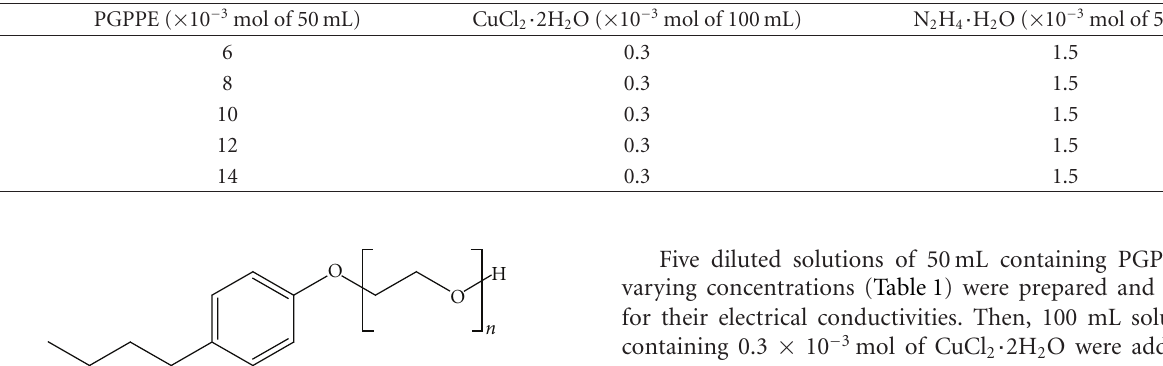
Table 1: Specifications of each solution with varying PGPPE concentrations.